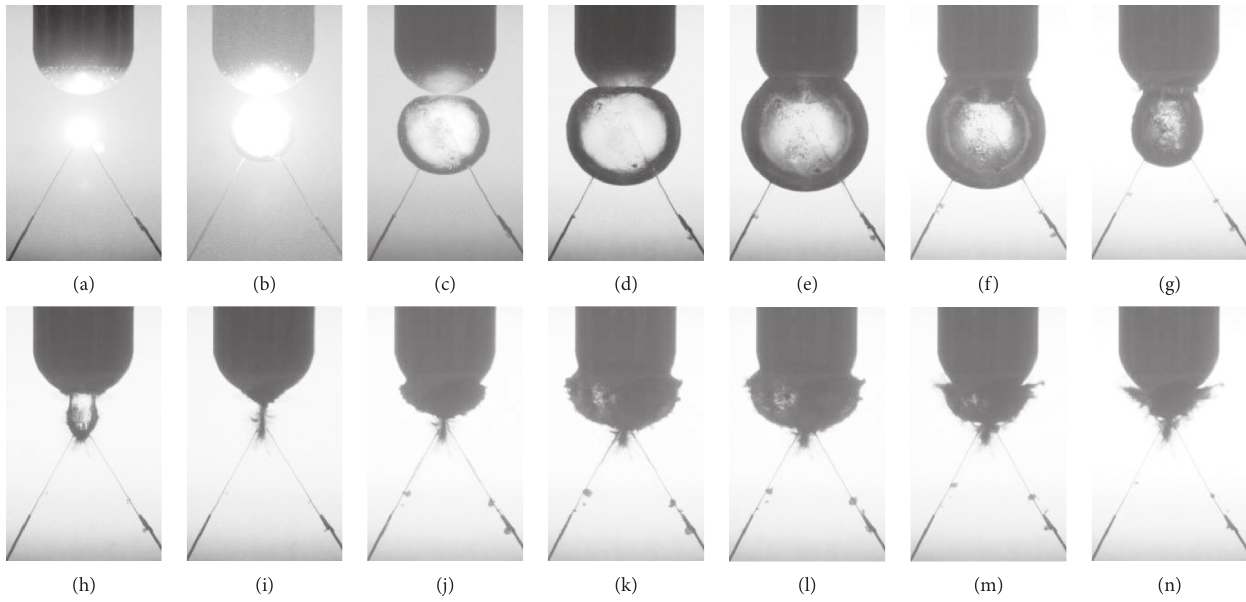
Figure 16: Bubble dynamics under the influence of hemispheric boundary for c � 0.67. (a) 0.000ms. (b) 0.542ms. (c) 1.024ms. (d) 1.791ms. (e) 2.833ms. (f) 4.125. (g) 5.541ms. (h) 5.999ms. (i) 6.124ms. (j) 6.499ms. (k) 7.499ms. (l) 8.124 ms. (m) 9.416ms. (n) 9.957ms.